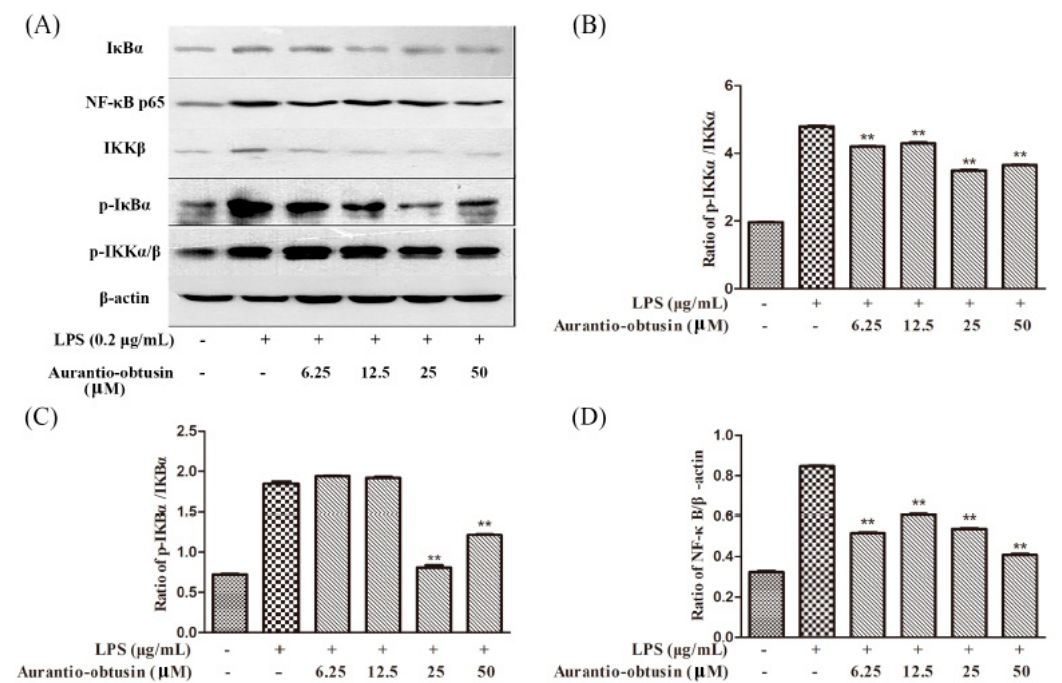
Figure 6. Effects of aurantio-obtusin on the expression of proteins associated with inhibition of NF- κ B in LPS-stimulated RAW264.7 mouse macrophages. RAW264.7 cells were pre-incubated with various concentrations (6.25–50 µ M) of aurantio-obstusin for 2 h, and stimulated with LPS (0.2 µ g/mL) for 12 h. The β -actin protein was used as the internal control. ( A ) Expression of proteins associated with the inhibition of NF- κ B was detected by a western blot analysis; Comparison of the levels of phosphorylated protein relative to the levels of their non-phosphorylated counterparts in the grey scale: p-IKK α / IKK α ( B ) and p-IKB α / IKB α ( C ); ( D ) Comparison of the levels of p65 relative to the level of their actin counterparts in the grey scale. ** p < 0.01 represent significance when compared to LPS-only treated cells.